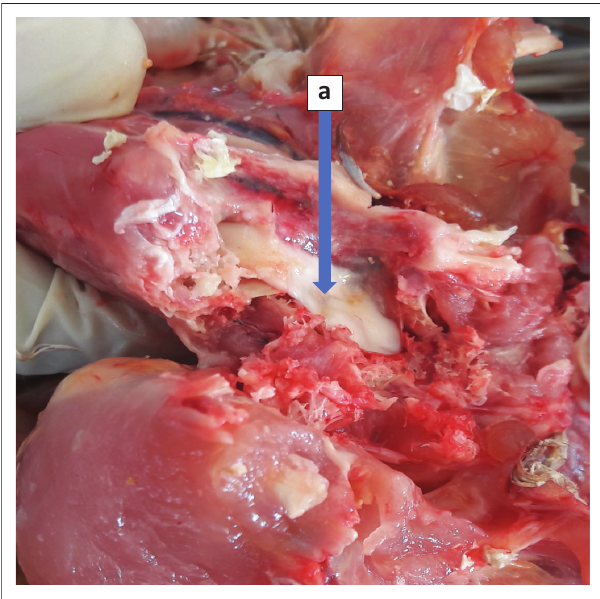
FIGURE 4: The exposed spinal cord with a clearly visible compression (a) lesion caused by the cyst.